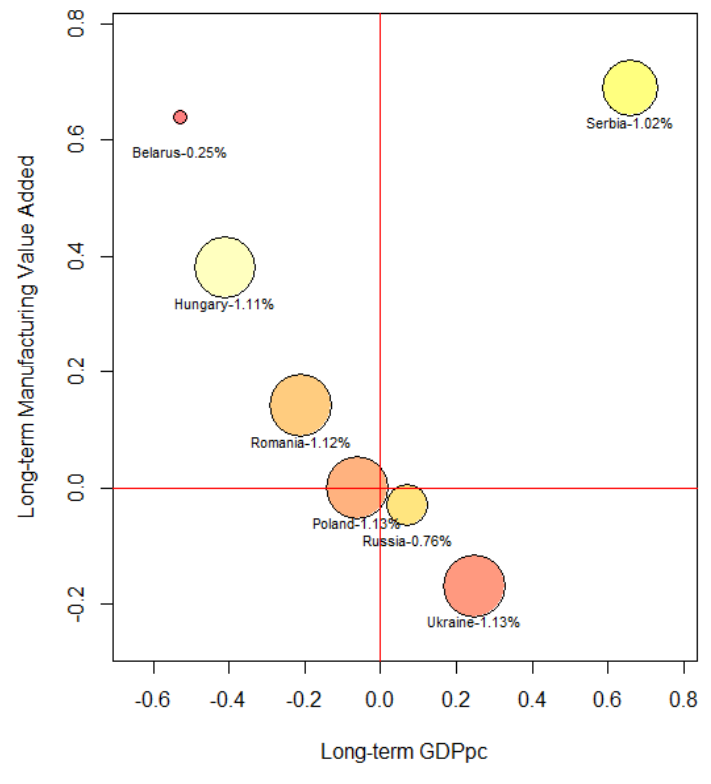
Figure 4. Long-term GDP per capita, manufacturing value added and